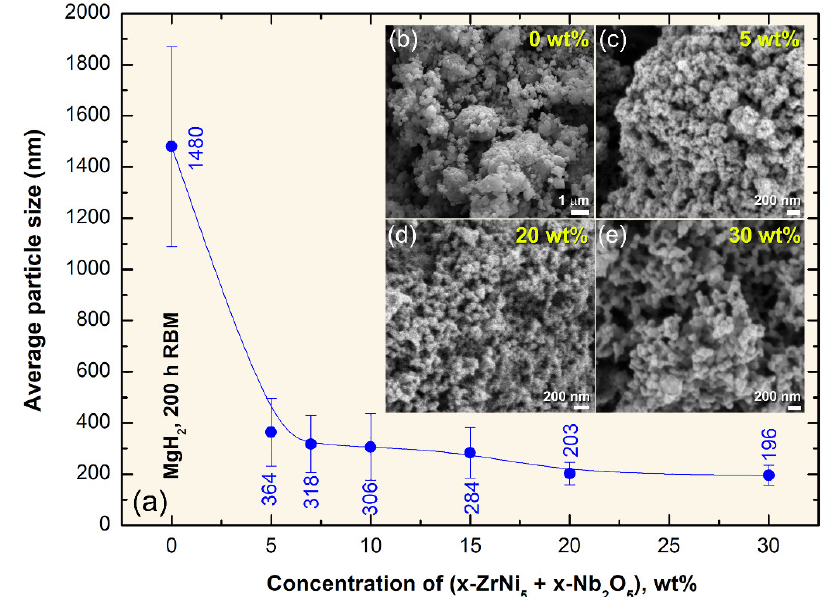
Figure 3. ( a ) Concentration effect of (x ZrNi 5 /x Nb 2 O 5 ) catalytic agent on particle size distribution of nanocomposite powders. Secondary electron beam - FE-SEM micrographs obtained with 1 kV for MgH 2 powders milled for 200 h of reactive ball milling (RBM) time is presented in ( b ) The FE-SEM micrographs of as-ball milled MgH 2 powders catalyzed with 5 wt% (2.5 ZrNi 5 /2.5 Nb 2 O 5 ) 20 wt% (10 ZrNi 5